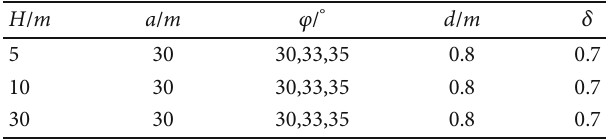
Table 4: Parameters of simulation.